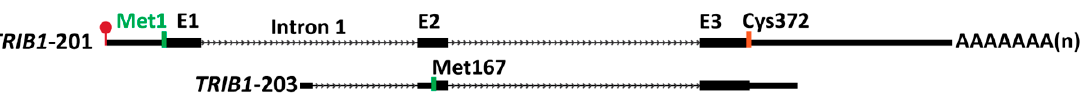
Figure 2. Example of annotated alternatively spliced TRIB transcript. Adapted from Ensembl and drawn to scale. N.B. Arrowed lines representing intronic sequences, which are removed from precursor TRIB1 -201 (ENST00000311922) and TRIB1 -203 (ENST00000520847) transcripts during splicing. Black rectangles and lines represent coding and non-coding sequences, respectively. Red dot and poly A tail highlight that the TRIB-201 transcript is capped and polyadenylated. Met1 and Met167 indicate assumed translation initiation codons. E = exon.